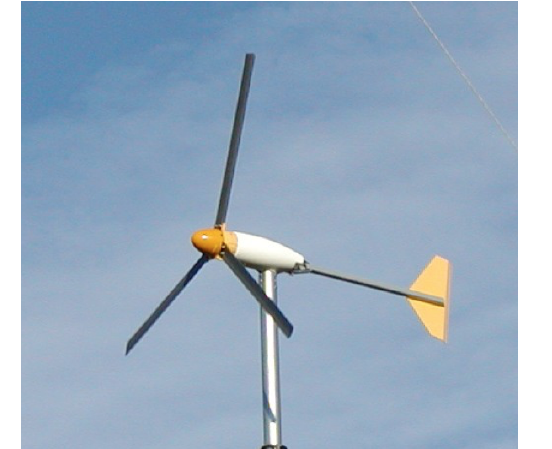
Figure 4. Bergey Excel 1.